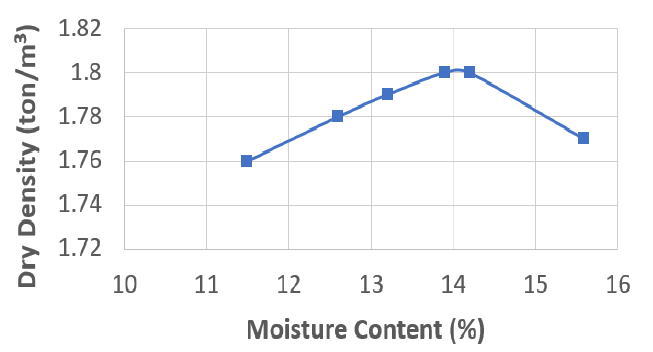
Figure 3. Dry density–moisture content relationship.